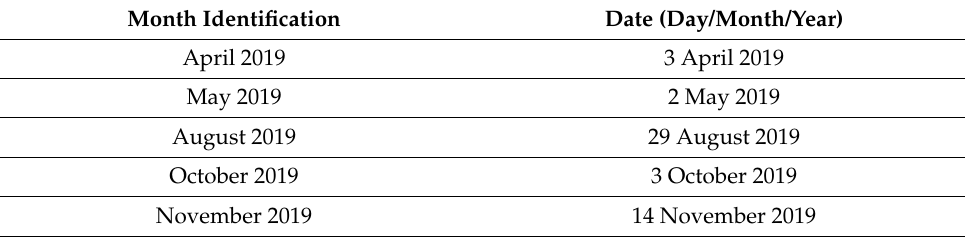
Table 3. UAV flights date over the Cell 1B in the five months